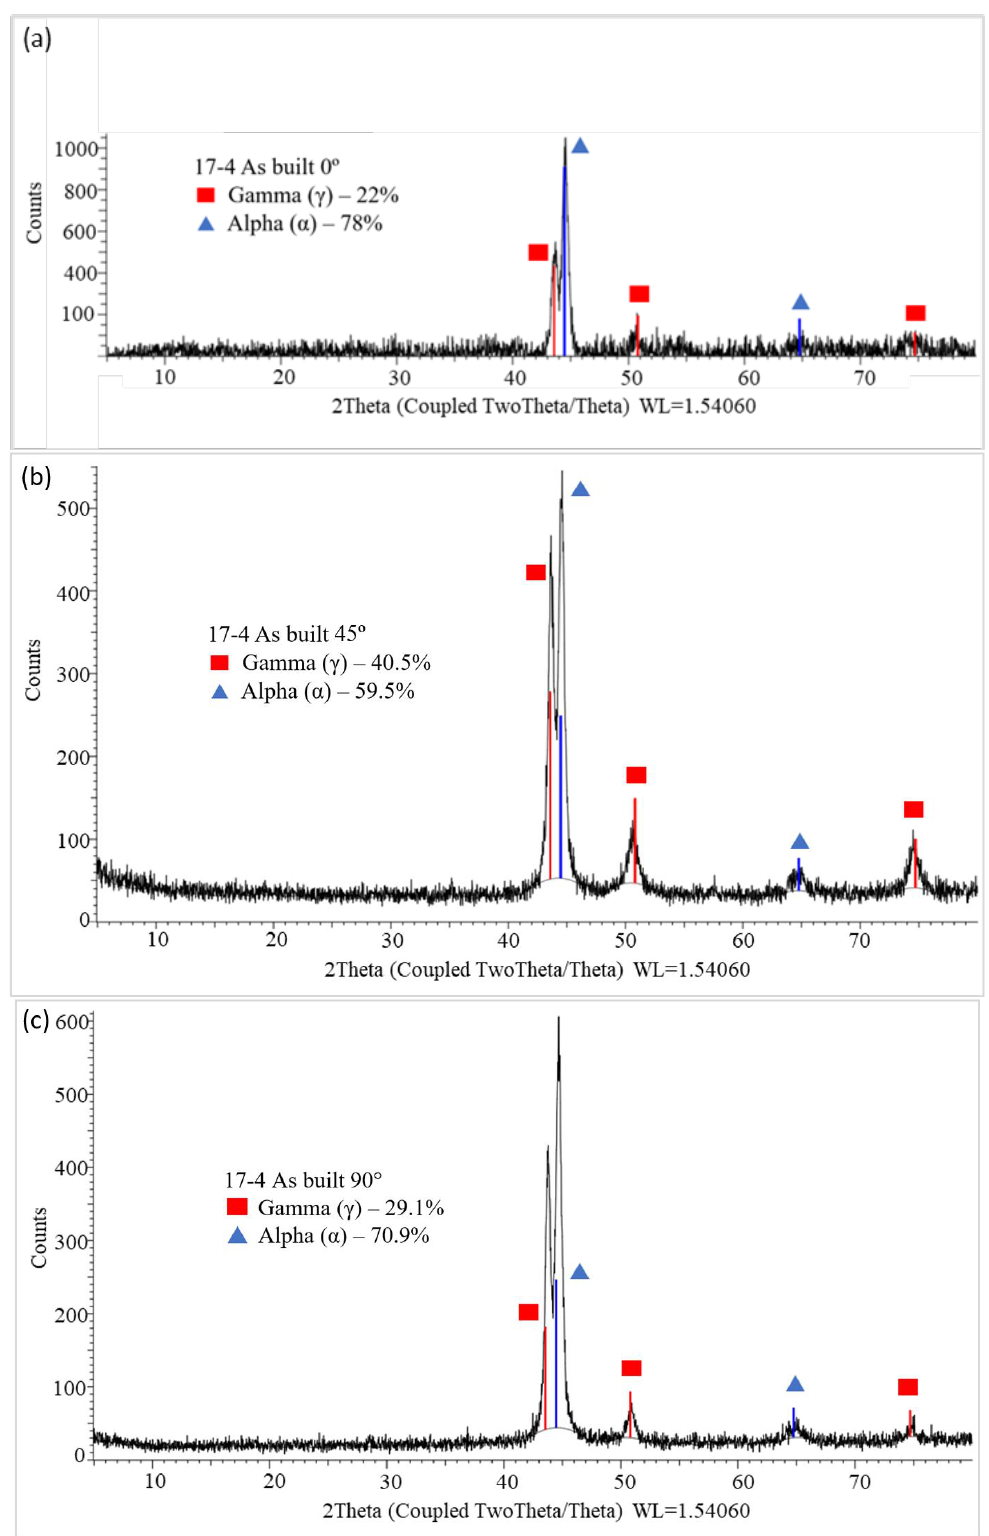
Figure 6. Volume fraction of phases recorded at ( a ) 0°, ( b ) 45° and ( c ) 90°. During the process of melting and cooling of the first layer, the amount of marten- site and retained austenite is the same because the rate of conversion from austenite to martensite depends only on the chemical composition of the powder. However,